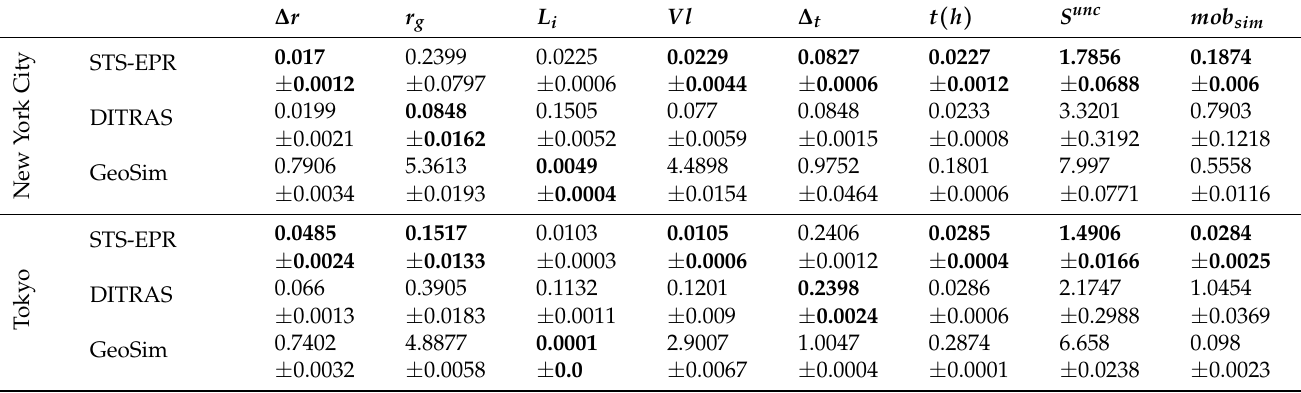
Table 4. Results of STS-EPR, DITRAS, and GeoSim for each city. The results refer to the squared spatial tessellation with tiles of 300 m. For each mobility measure, we show the average and standard deviation of the KL divergence of five generation